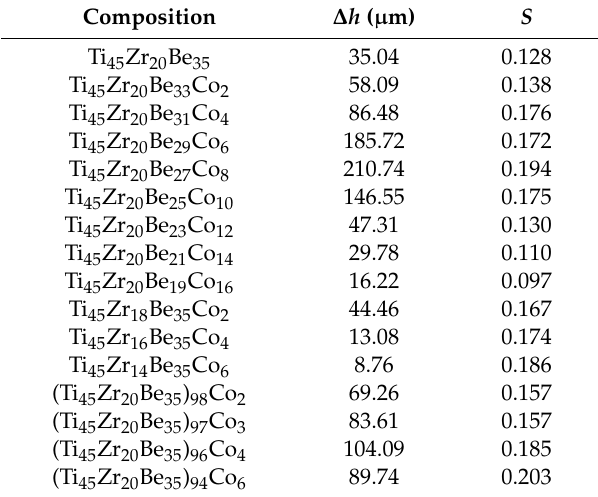
Table 3. Experimental determined values of ∆ h and S parameter of developed Ti-Zr-Be-Co BMGs. Composition ∆ h ( µ